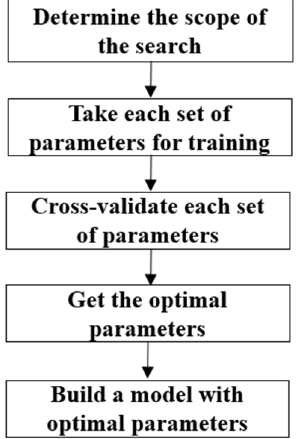
Figure 5. Cross-validation based on grid search